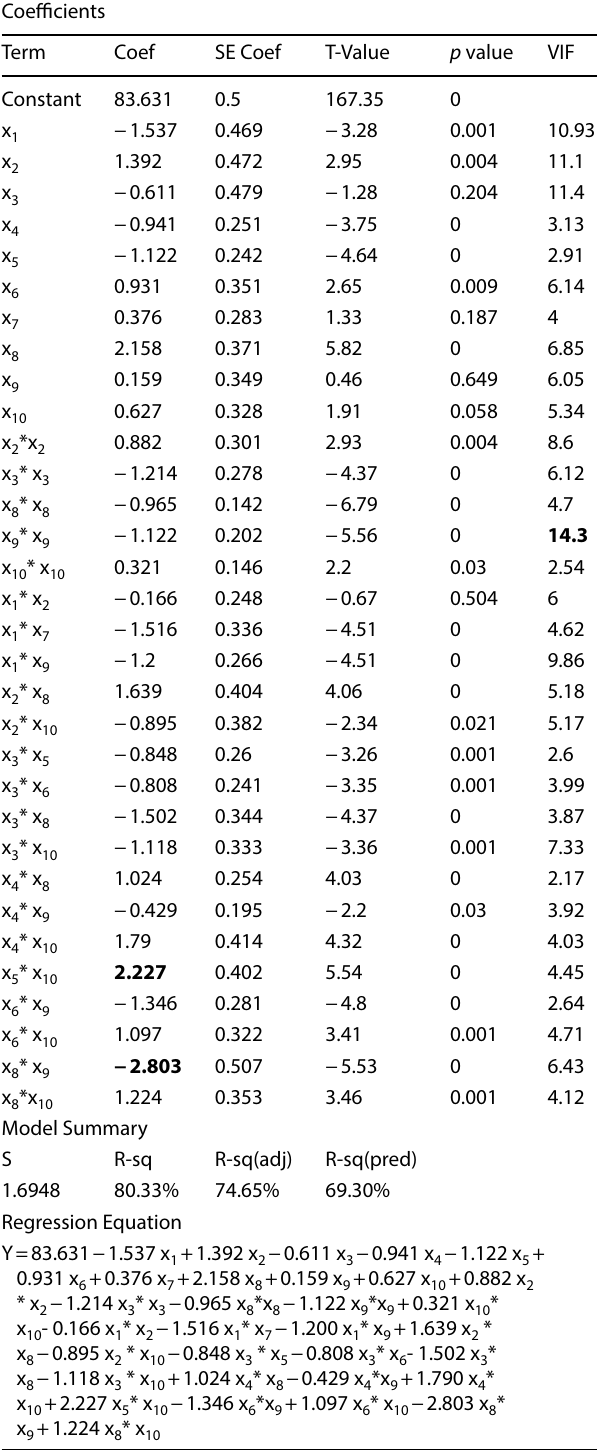
Table 8 Results of the stepwise algorithm on the first